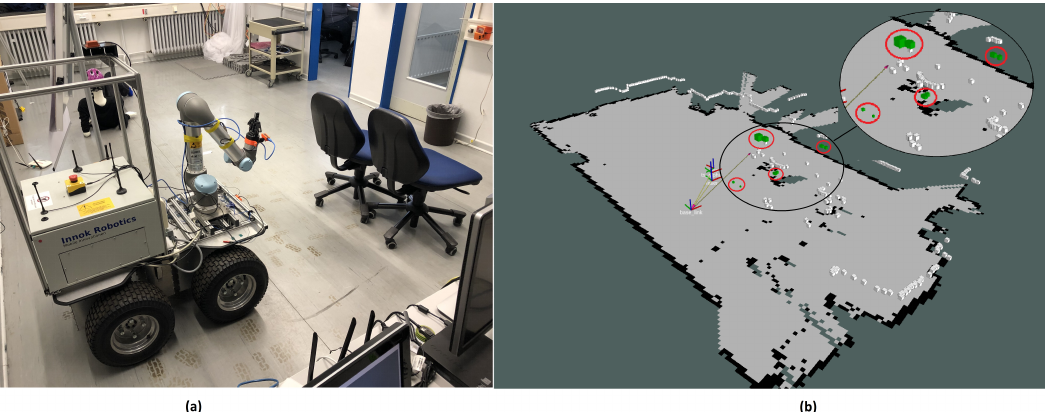
Figure 2. ( a ): Real environment and ( b ): Ground truth LiDAR (white boxes) and 3D US data (green boxes). For convenience, the occupancy grid map using 2DSLAM [16] is included. The LiDAR cannot detect chair’s legs and far corner marked as red circles in ( b